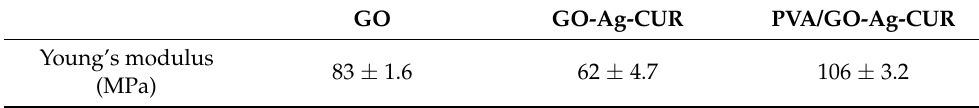
Table 4. Young’s modulus for GO, GO-Ag-CUR, and PVA/GO-Ag-CUR